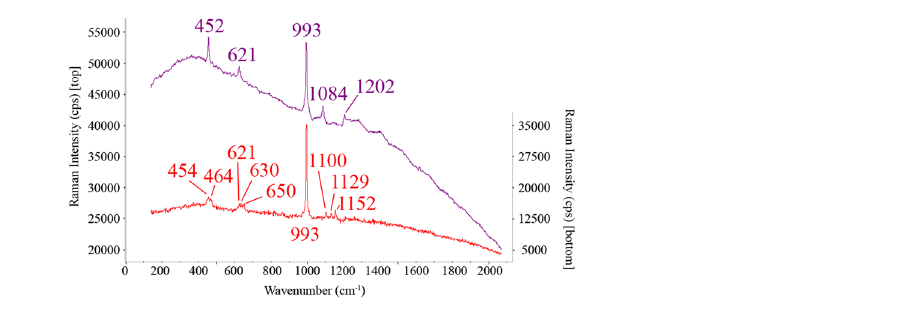
Figure 3. Raman spectra of aphthitalite (top) obtained in the A2 wall and thenardite (bottom) from the A4 wall in the